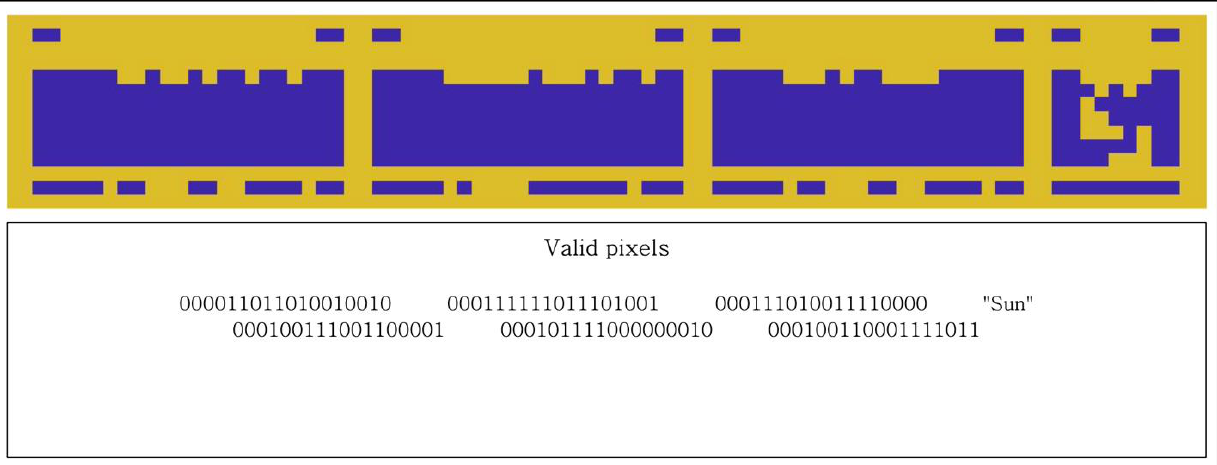
Figure 19. A section of the message indicating the position of our Solar system using globular clusters coordinates in the message, page 13.